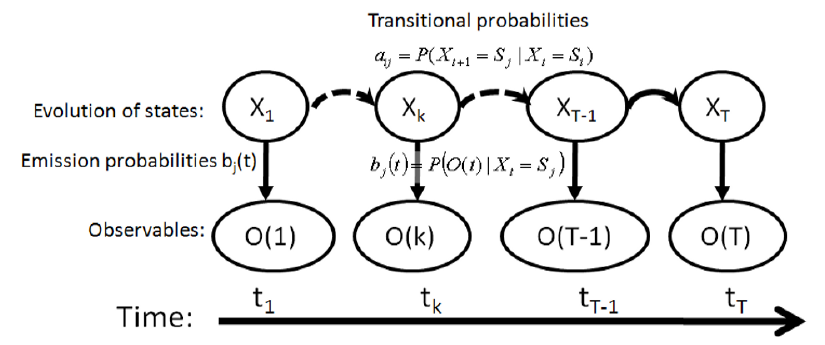
Figure 5. The representation of a physical system by a hidden Markov